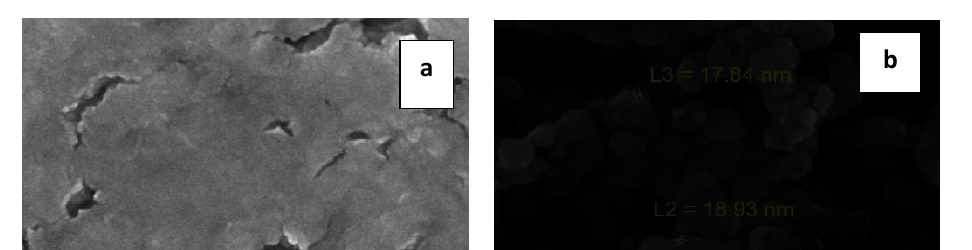
O thin film: (a) Seed layer, (b) Growth layer. 3 4